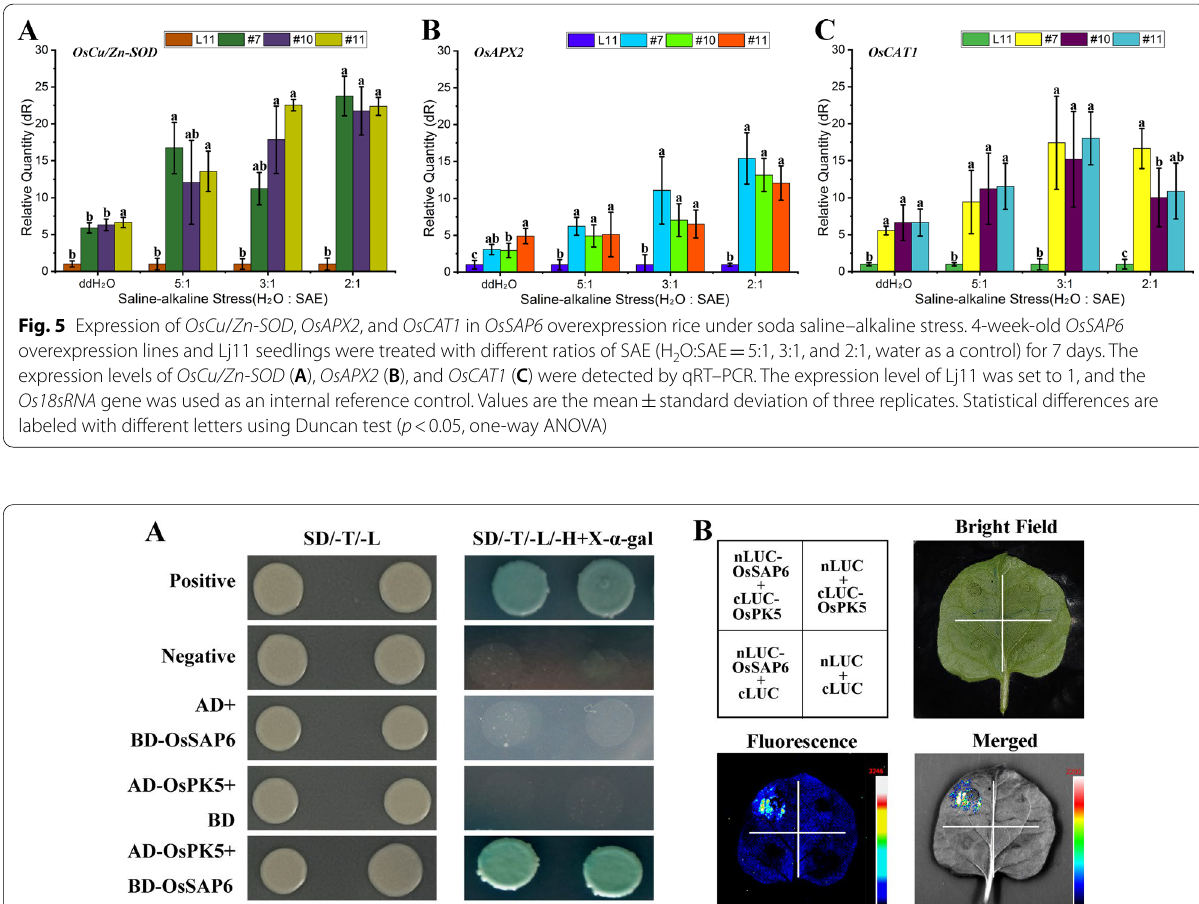
Fig. 6 Interactional analysis between OsSAP6 and OsPK5. A OsSAP6 was found to interact with OsPK5 in a yeast two-hybrid assay. pGADT7- OsPK5 was validated by cotransforming Y2HGold yeast cells with pGBKT7- OsSAP6 plasmid, and strong interaction were found in medium SD/-Trp-Leu-His containing X ‐ α ‐ gal. B Interaction of OsSAP6 and OsPK5 in N. benthamiana leaves was analyzed by LCI